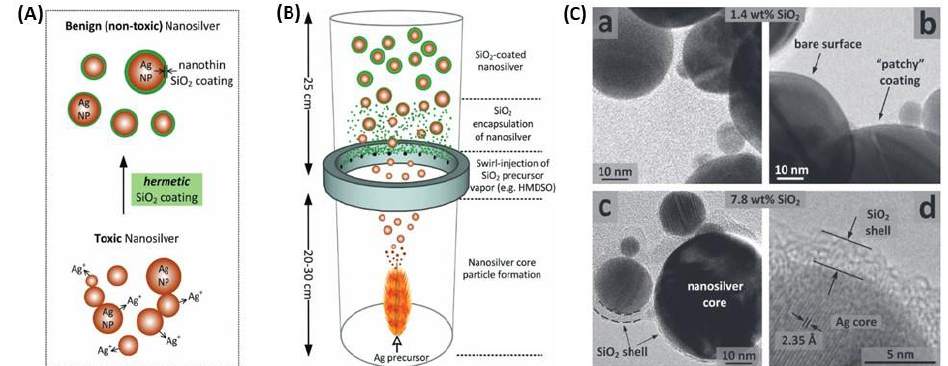
Figure 14. ( A ) Effect of a hermetic SiO 2 coating on the flocculation and toxicity of nanosilver particles. ( B ) Illustration of the nanosilver encapsulation with a hermetic SiO 2 coating using hexamethyldisiloxane as silica precursor in a flame aerosol reactor. ( C ) TEM images of the (a,b) 1.4 wt.% and (c,d) 7.8 wt.% SiO 2 -coated nanosilver. Adapted from [142]. Copyright (2010), WILEY-VCH Verlag GmbH & Co. KGaA,